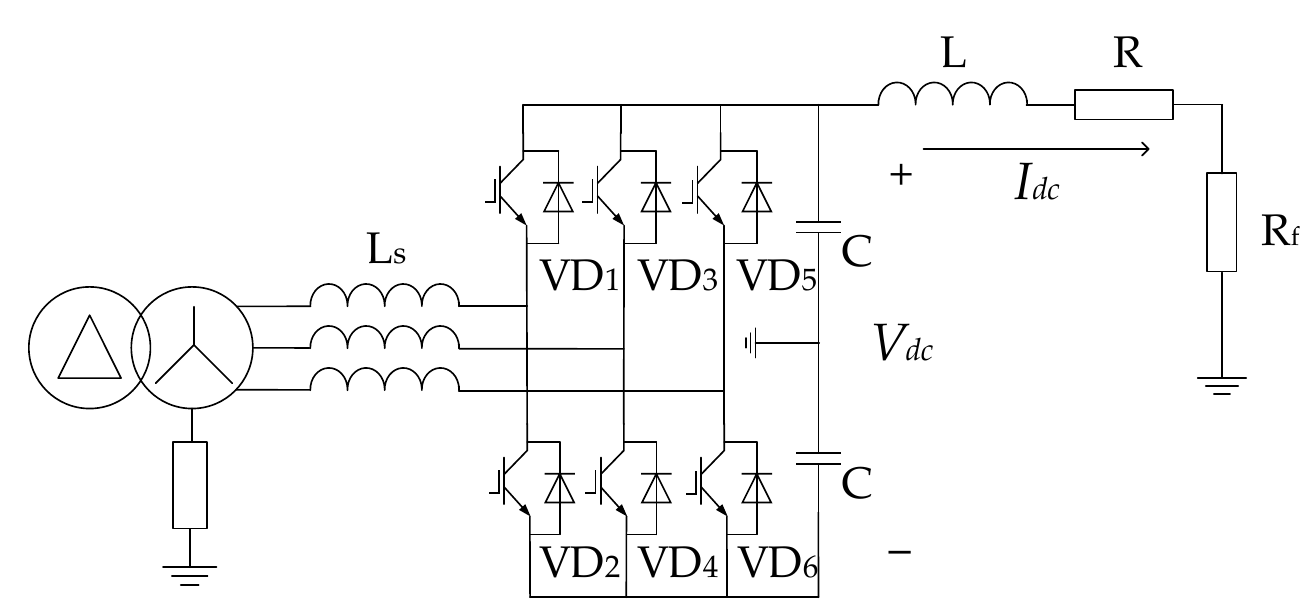
Figure 2. Equivalent circuit for monopolar grounding.